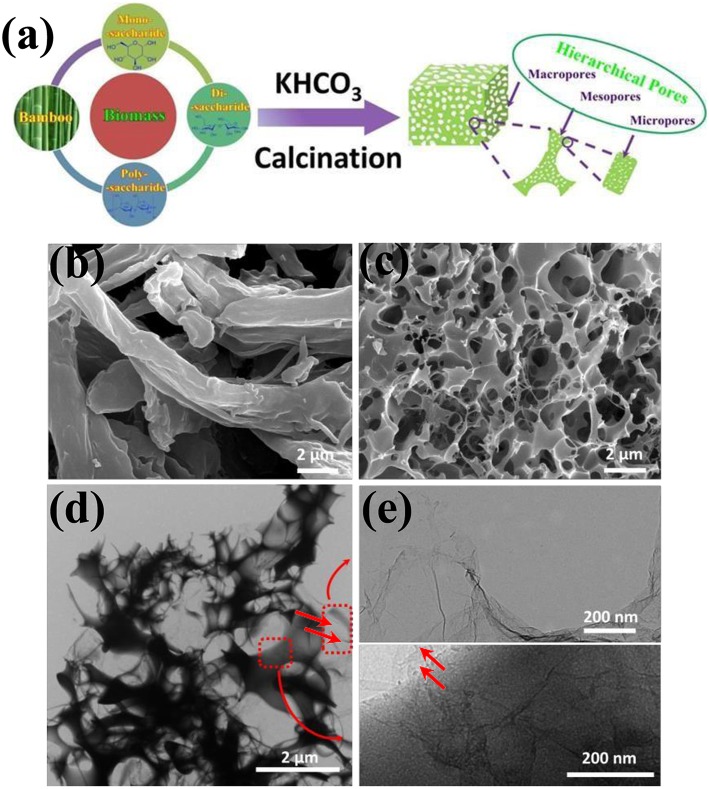
(a) Scheme diagram of the formation of HPC by “leavening” agent; (b–e) SEM and TEM images of HPC. Reprinted with permission from Deng et al. (2015). Copyright 2015 Royal Society of Chemistry.